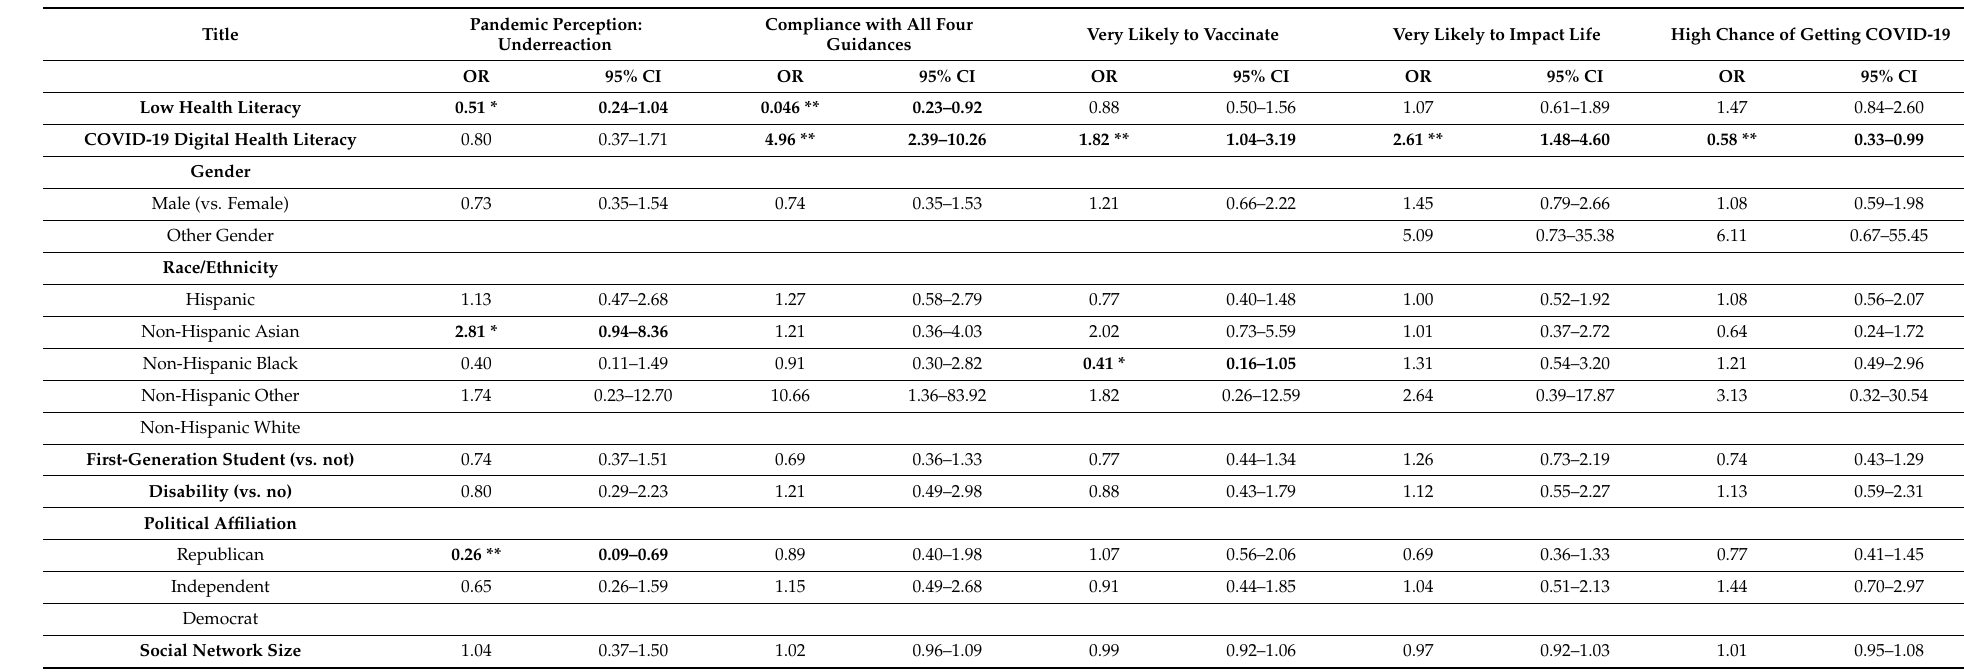
Table 3. Multivariable models predicting pandemic